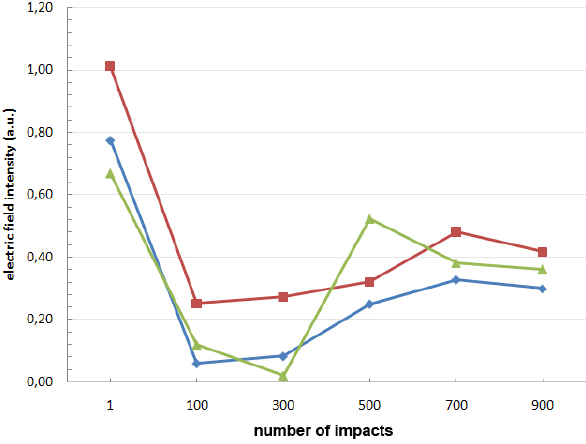
Figure 4. Decrease in the EM emissions magnitude during repeated impacts on shale (red), granite (green), and quartz (blue)